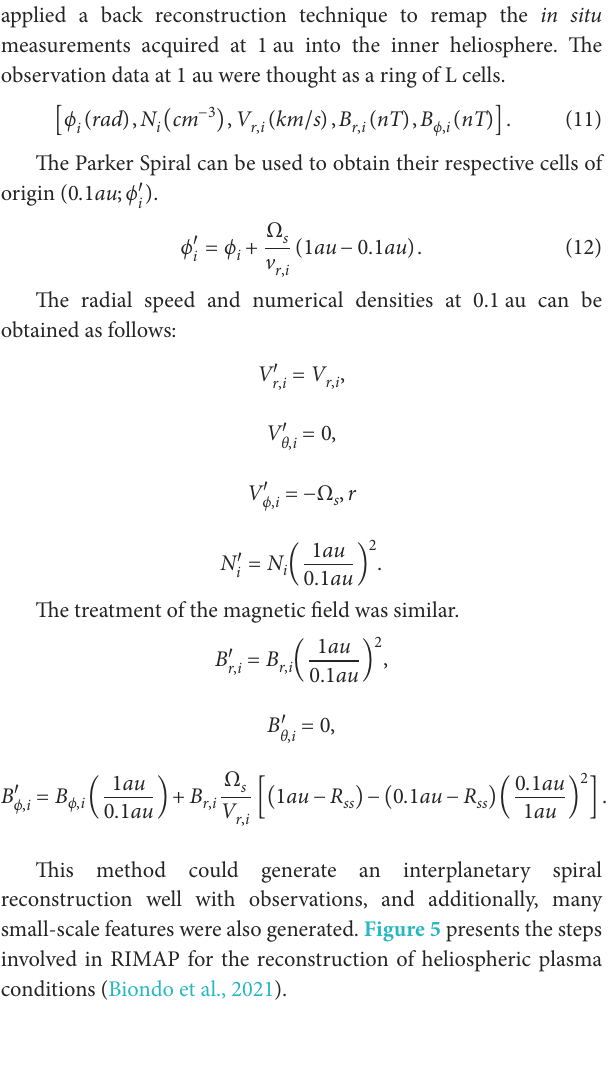
orientation derived by the PFSS + SCS model. The radial velocity at 0.1 au was obtained with different forms for Wiengarten et